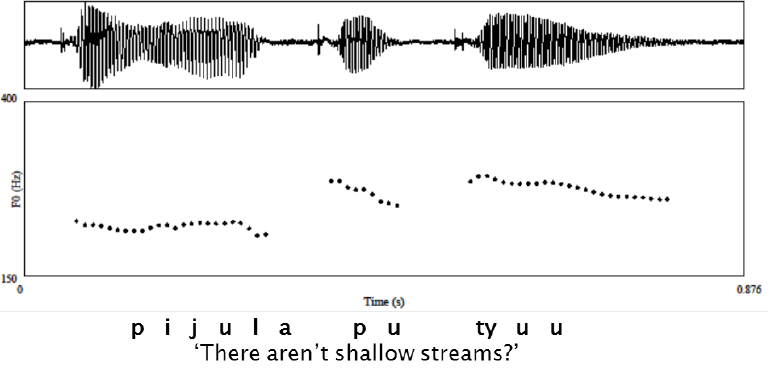
Figure 4. Cha’palaa polarity question intonation; last syllables are mid/high plateau. In selection represented